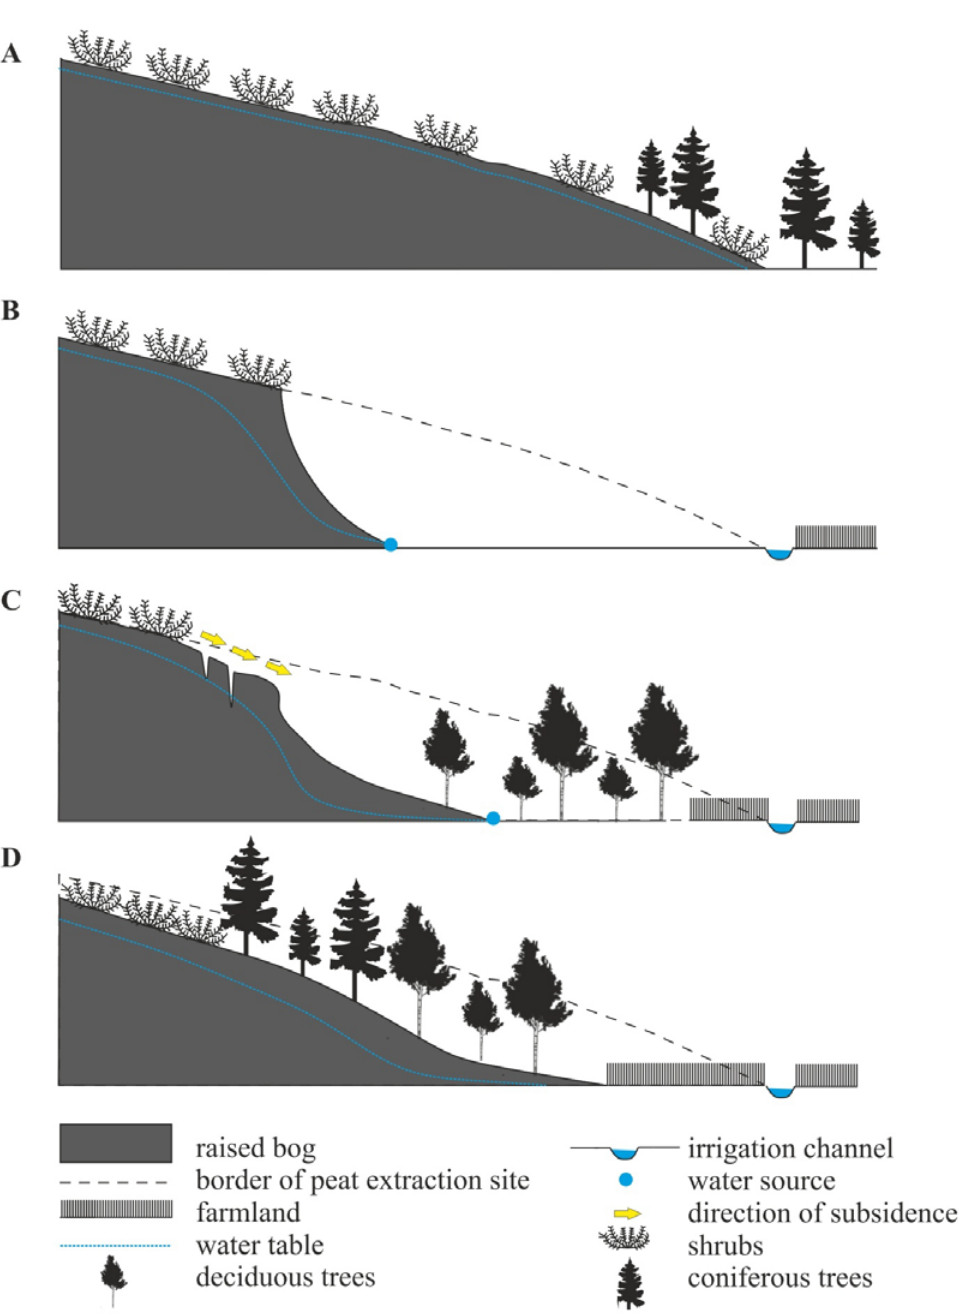
Figure 7. Schematic cross-sections of the transition between raised bog and cutover areas, before and after peat excavation (after Łajczak 2006,